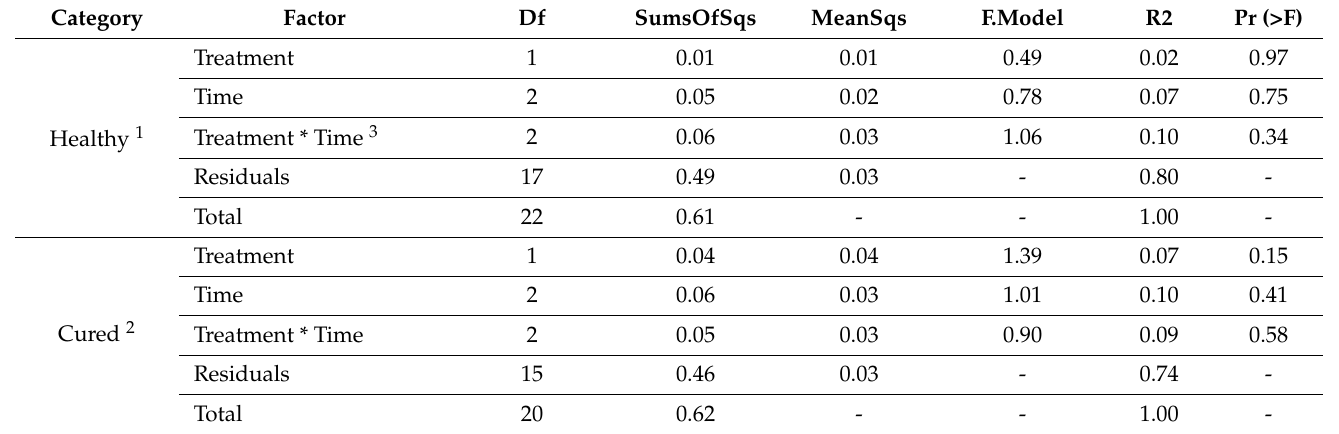
Figure 2. Beta diversity of bacterial communities of the milk samples. Principal coordinate analysis (PCoA) showing the Bray-Curtis dissimilarities in the composition of bacterial communities between milk sample grouped according to category (Healthy and Cured), treatment (ITS and DCT+ITS), and time of sampling (0 d: the day of drying-off, 7 d: 7 days after calving, and 14 d: 14 days after calving). Individual points in each plot represent a milk sample, while different colors and shapes represent treatments and time of sampling, respectively. Percentages shown along the axes represent the proportion of dissimilarities captured by PCoA in a two-dimensional (2D) coordinate space.